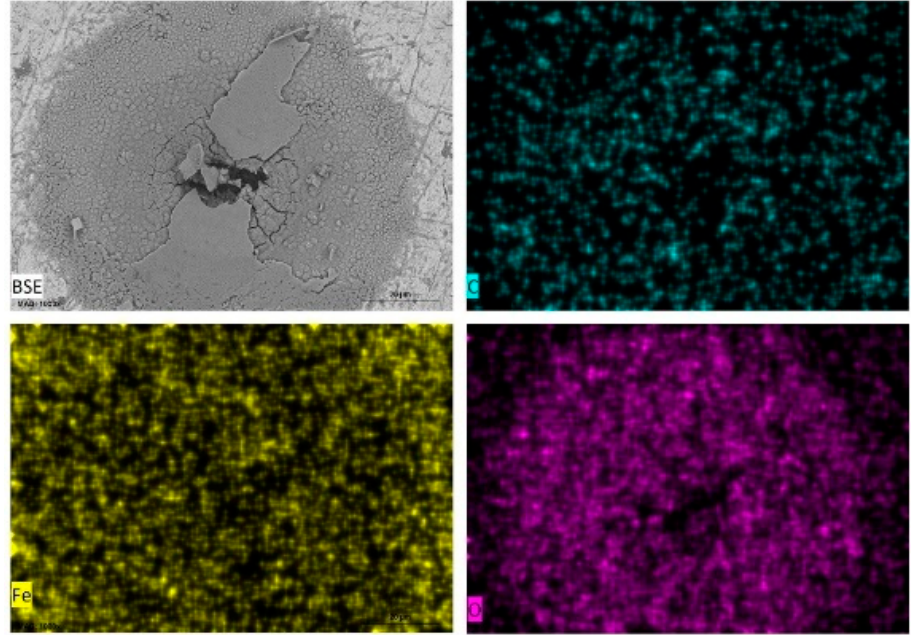
Figure 7. SEM/EDS mapping images of carbon steel sheet (CR1 ≈ EN 1.0338) surfaces after immer- sion in pineapple juice (pH = 3.94).